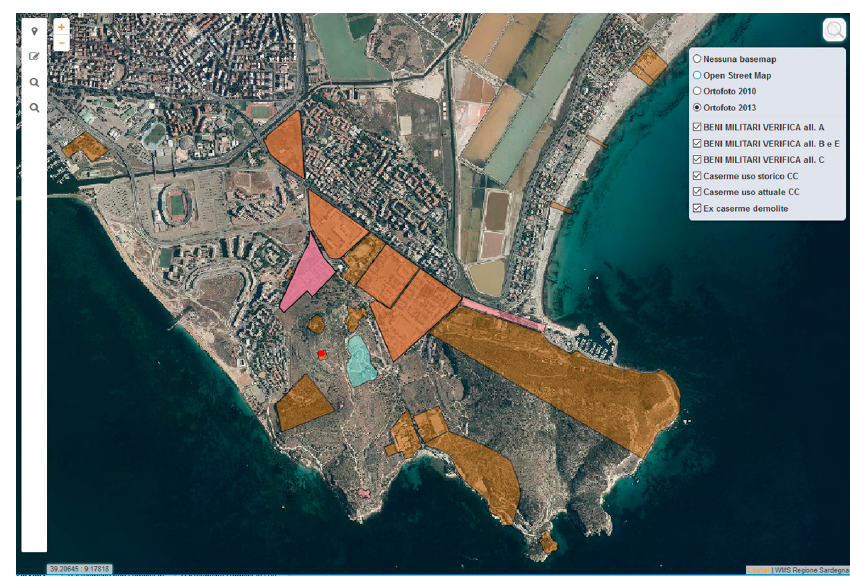
Figure 11. 3D Visualization Project (S. Ignazio Fort).